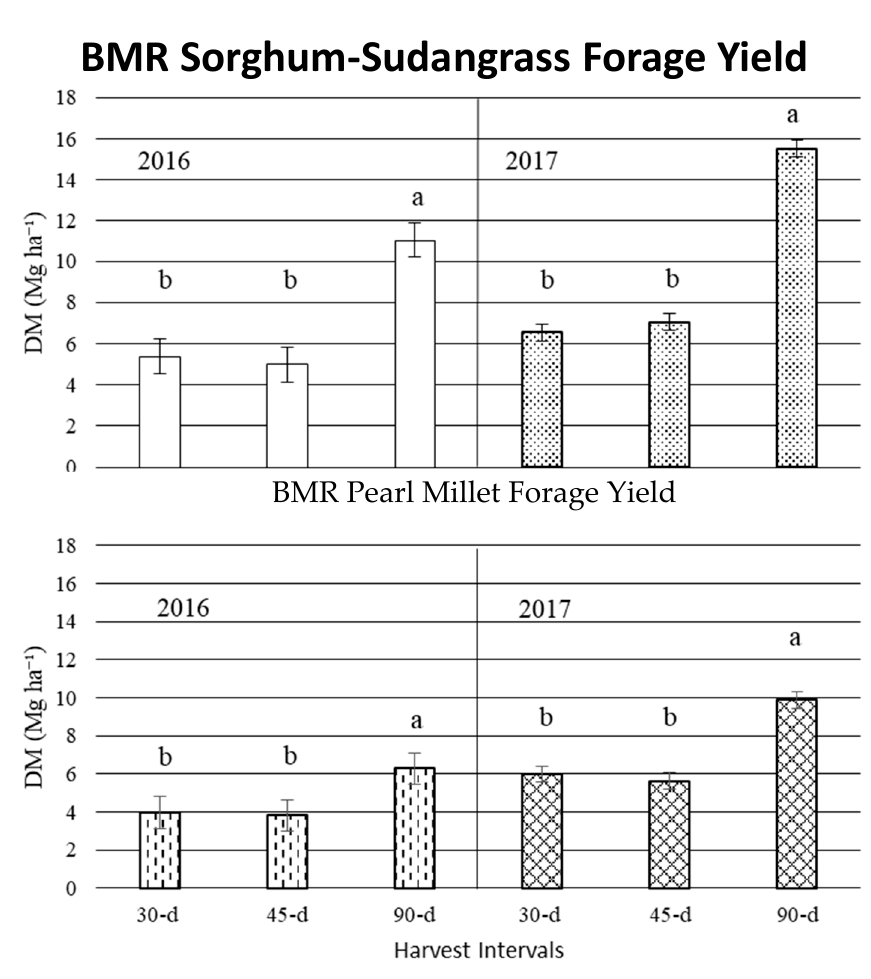
Figure 1. Average total (summed across harvest intervals) brown midrib (BMR) sorghum-sudangrass and BMR pearl millet aboveground dry matter (DM) in Canyon, TX during 2016–2017. The same lowercase letter represents similar means within year, within crop ( α < 0.05).